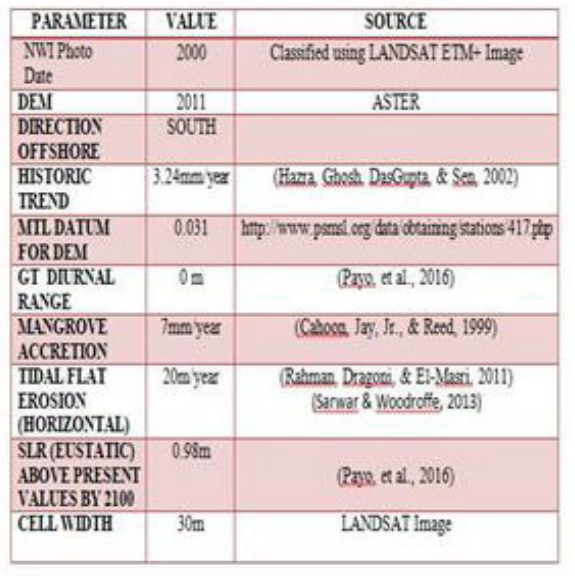
Table 4: Input Parameters with Value for SLAMM